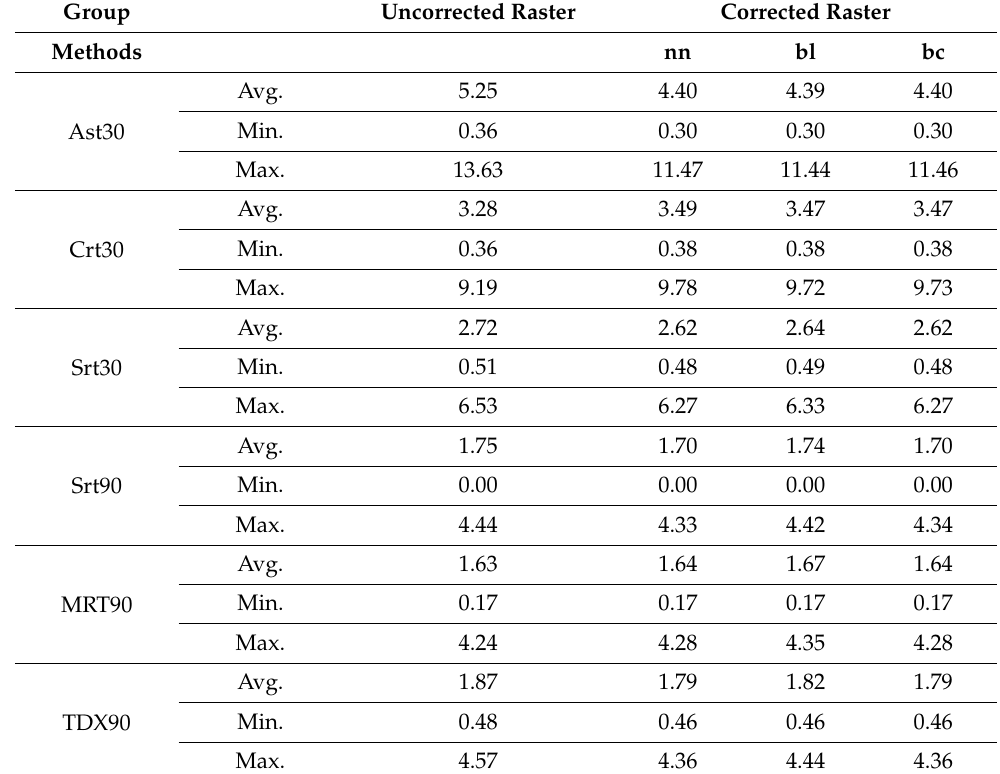
Table 10. Slope values (in degree) calculated at GCPs for space-borne elevation data sets. The nn, bl, and bc refer to the interpolation methods (nearest neighbour, bilinear, and bicubic, respectively) used in the extraction of elevation values from space-borne DEMs over the GCPs. Group Uncorrected Raster Corrected Raster